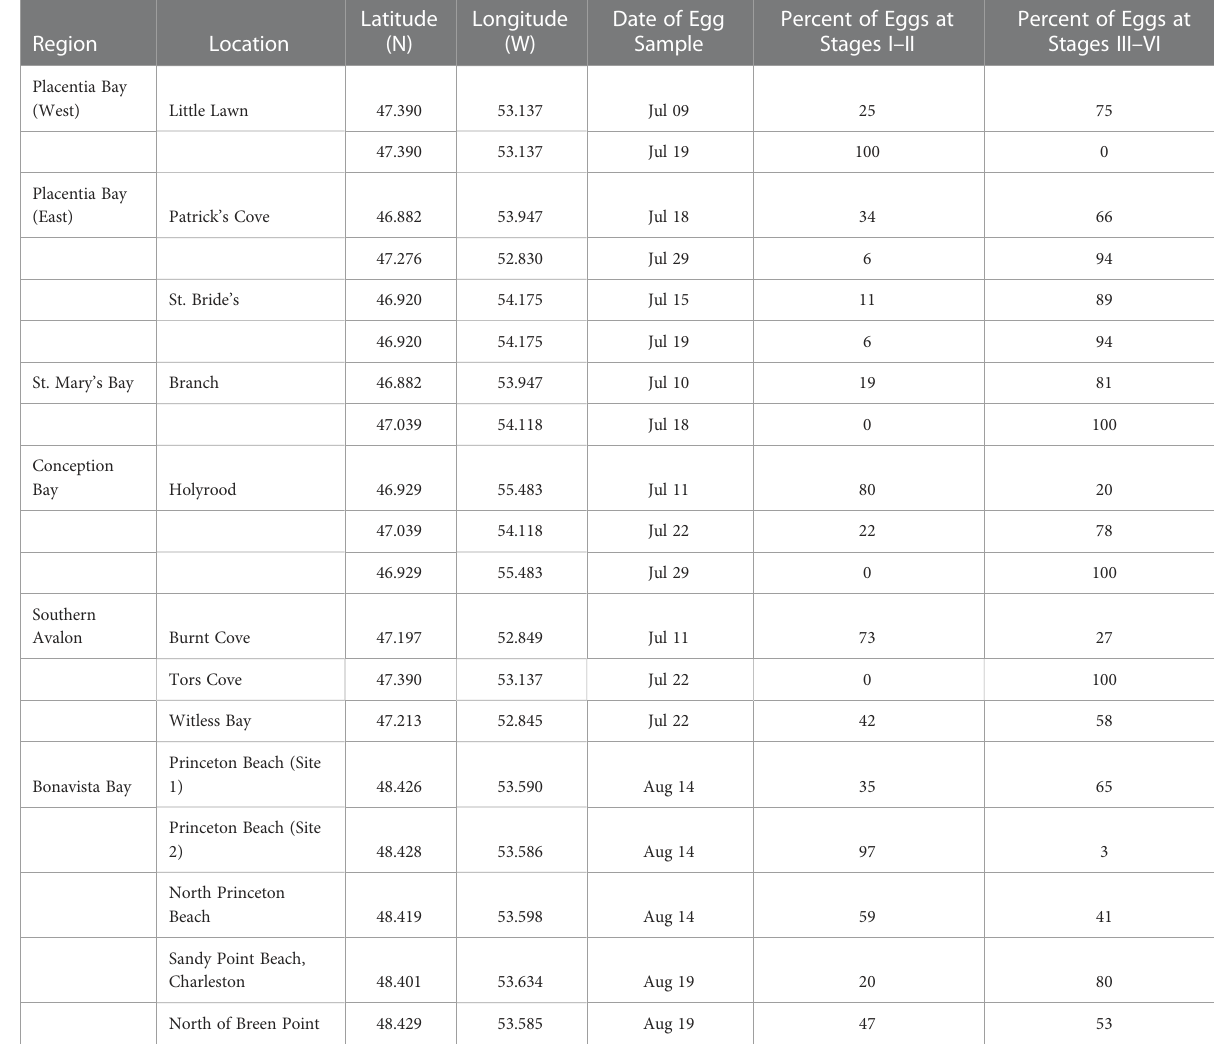
TABLE 1 Beach capelin egg sampling in Newfoundland during July and August 2019 indicating the sampling location, date and the percentage of capelin eggs in early developmental stages (i.e. Stages I – II) and late developmental stages (i.e. Stages III – VI).